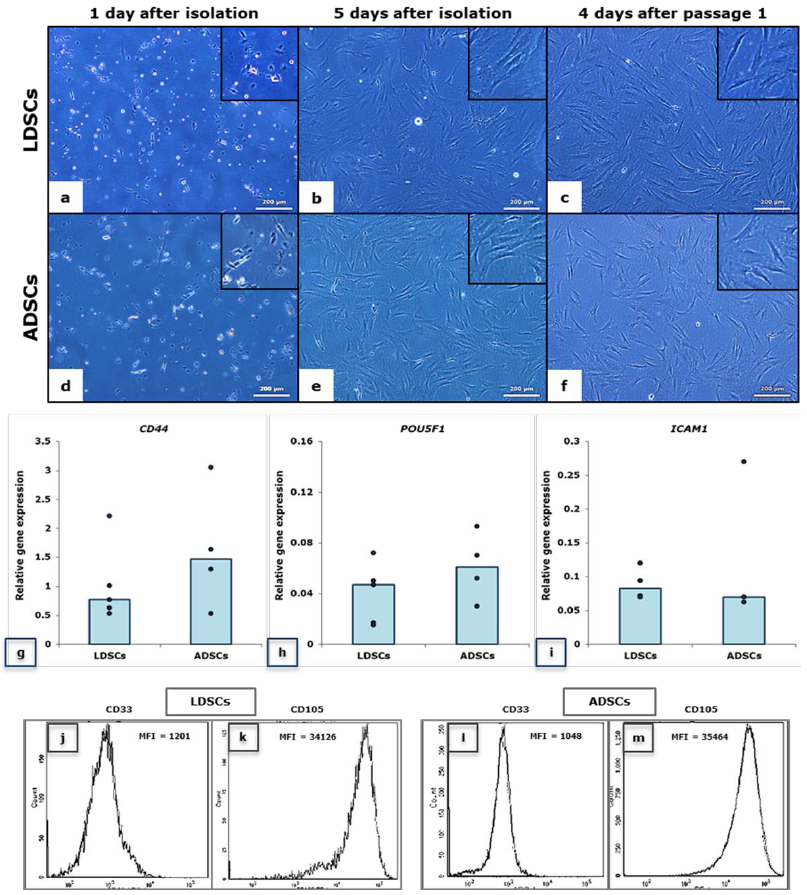
Figure 1. Morphology of lipoma-derived stem cells (LDSCs) ( a , b , c ) and adipose-derived stem cells (ADSCs) ( d , e , f ); images were acquired at day 1 ( a , d ), at day 5 after isolation ( b , e ) and at day 4 after passage 1 ( c , f ), on phase contrast with objective magnification 10×, cells are spindle-like in shape which is typical for mesenchymal stem cells ( b , c , e , f ); Relative expression of CD44 ( g ), POU5F1 ( h ) and ICAM1 ( i ) genes in LDSCs and ADSCs at passage 2, normalized to GAPDH , presented as scatterplots with median, each dot represents one patient-derived cell culture per group, sample size for CD44 and POU5F1 : n(LDSCs) = 5 and n(ADSCs) = 4, for ICAM1 : n(LDSCs) = 4 and n(ADSCs) = 4; Flow cytometric analysis of CD105 ( k , m ) and CD33 ( j , l ) cell surface marker expression in LDSCs ( j , k ) and ADSCs ( l , m ) at passage 2 (representative histograms per each group of samples), MFI—mean fluorescence